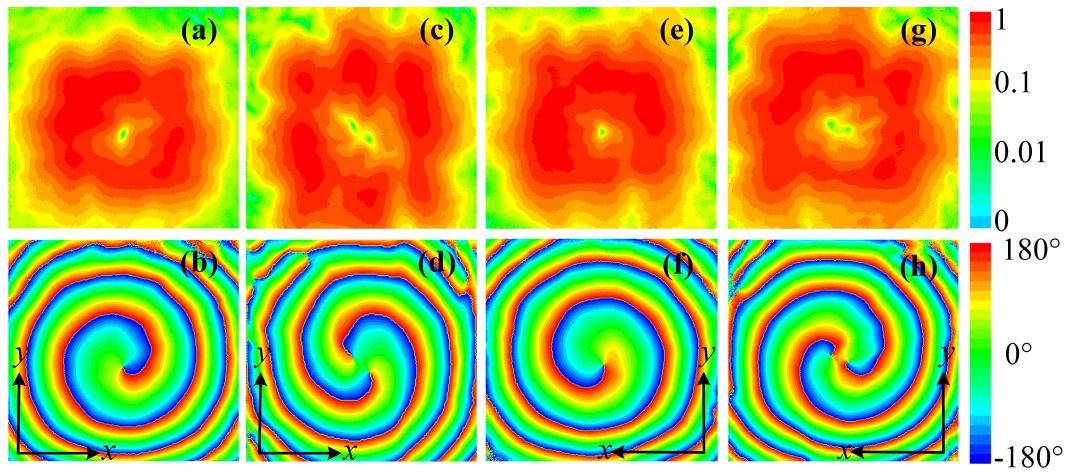
Figure 10. Measured cross-polarized electric field distributions of the transmitted OAM carrying beams at a transverse plane 250 mm away from the metasurface: ( a ) Amplitude and ( b ) phase distributions for OAM order of l = + 1. ( c ) Amplitude and ( d ) phase distributions for OAM order of l = + 2. ( e ) Amplitude and ( f ) phase distributions for OAM order of l = − 1. ( g ) Amplitude and ( h ) phase distributions for OAM order of l = −